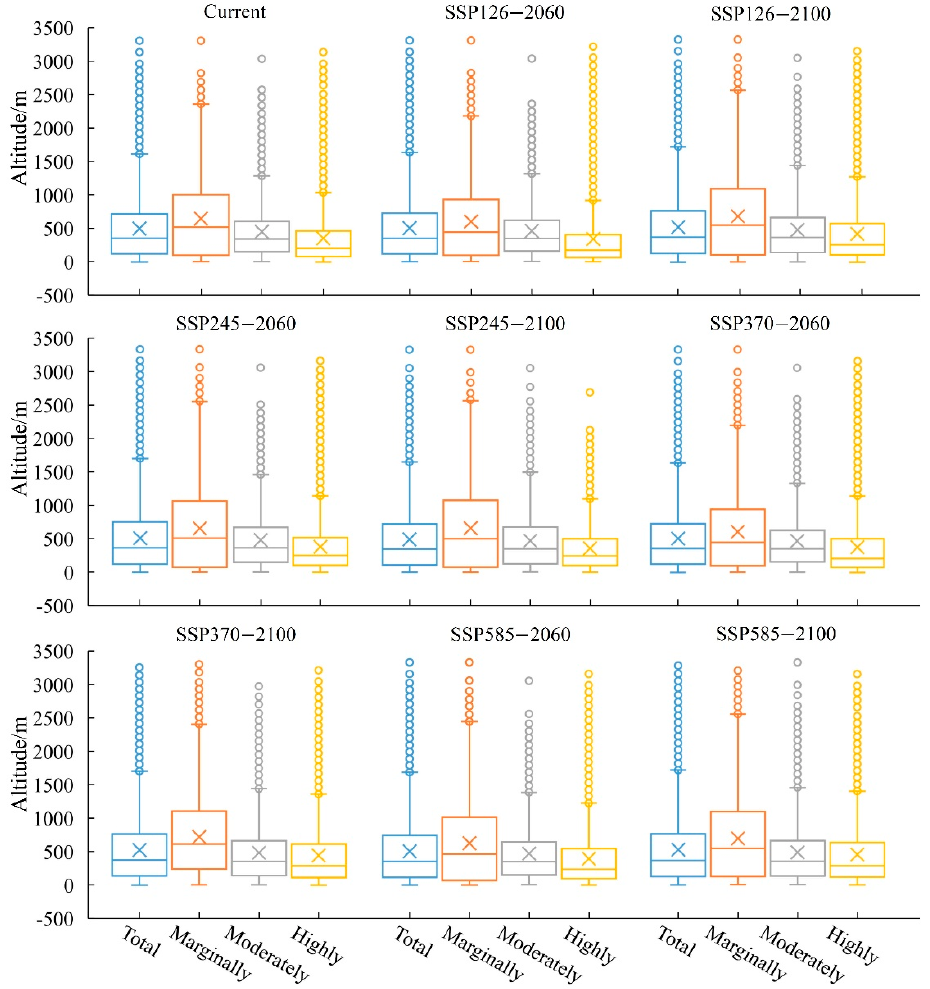
Figure 3. Altitude changes under current and future climate scenarios. Blue refers to total suitable habitat; orange refers to marginally suitable habitat; gray refers to moderately suitable habitat; yellow refers to highly suitable habitat.